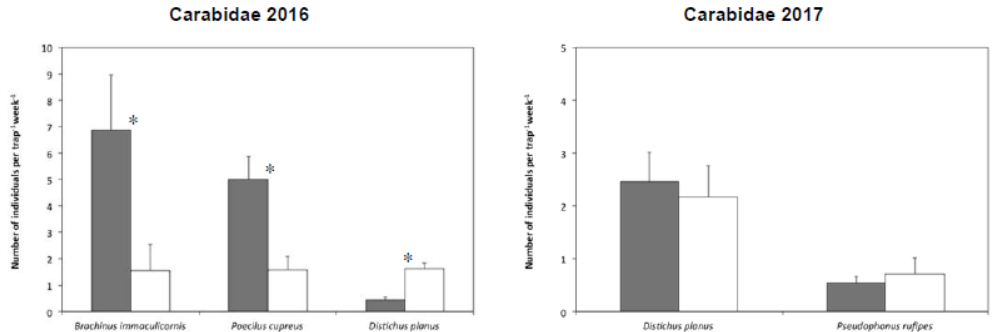
Figure 4. Mean number of individuals caught per trap per week of the dominant species of Carabidae collected in the experimental plots of tomato, where the cover crops were terminated either with a roller crimper (IL-RC, dark grey bars) or through green manuring (GM, white bars). Lines represent the standard errors of the means; * = significant differences for each species as detected by ANOVA. Table 5. Results of ANOVA carried out on the most abundant species of Carabidae (pooling all the individuals caught in each plot over the whole sampling period) in cauliflower plots.